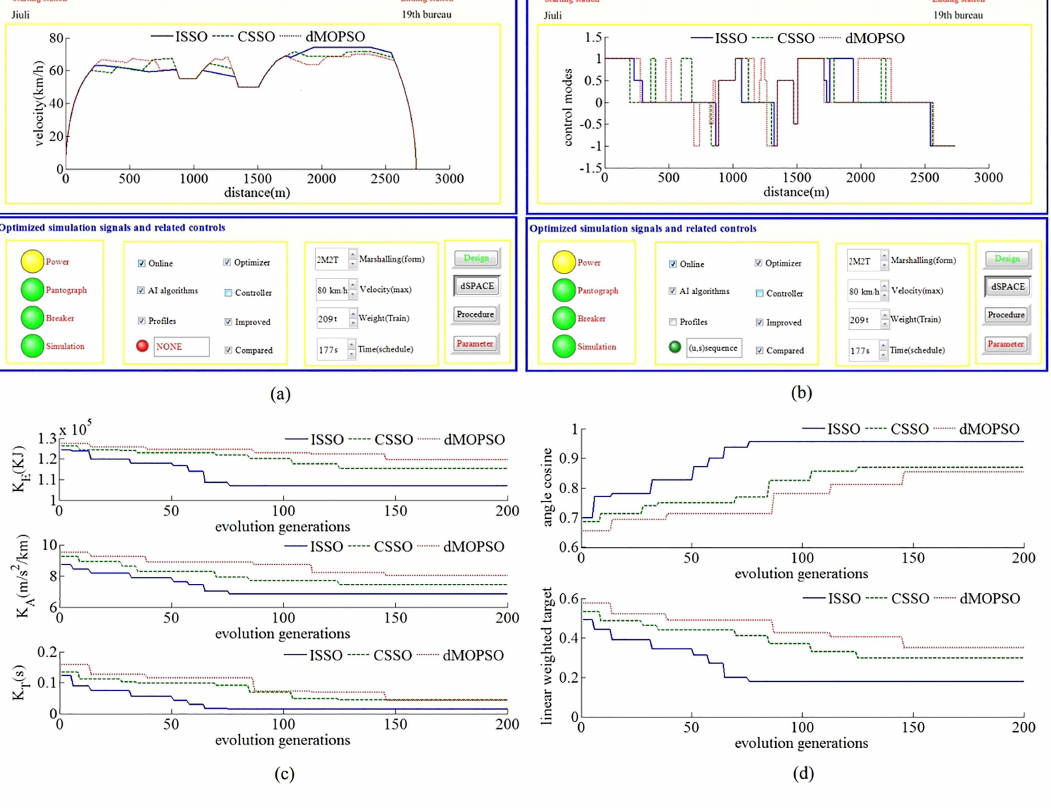
Figure 10. The HILS optimization curves of different algorithms for Jinpu line No.1 in Dalian scenario. ( a ) Target velocity trajectory profiles. ( b ) Operating condition distance curves. ( c ) Iterative convergence curves of each optimization objectives. ( d ) Iterative convergence curves of unified goals. Table 8. The Matlab/simulink evaluate results of different algorithms for rail transit line No.12 in Dalian